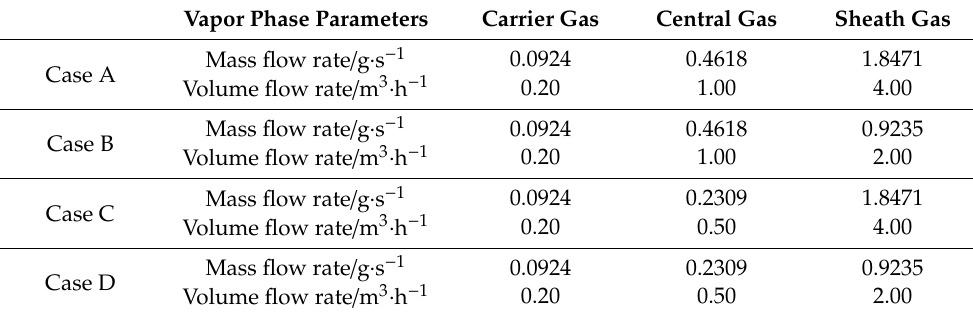
Table 1. Gas flow rate set in each inlet